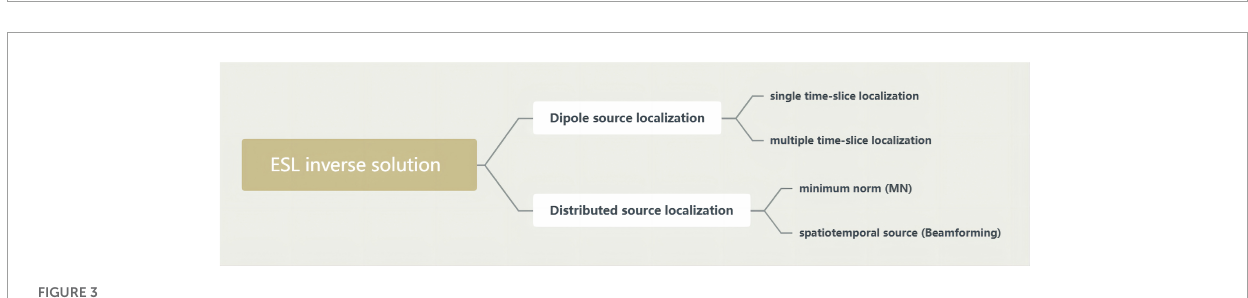
FIGURE2 Functional connectivity metrics.